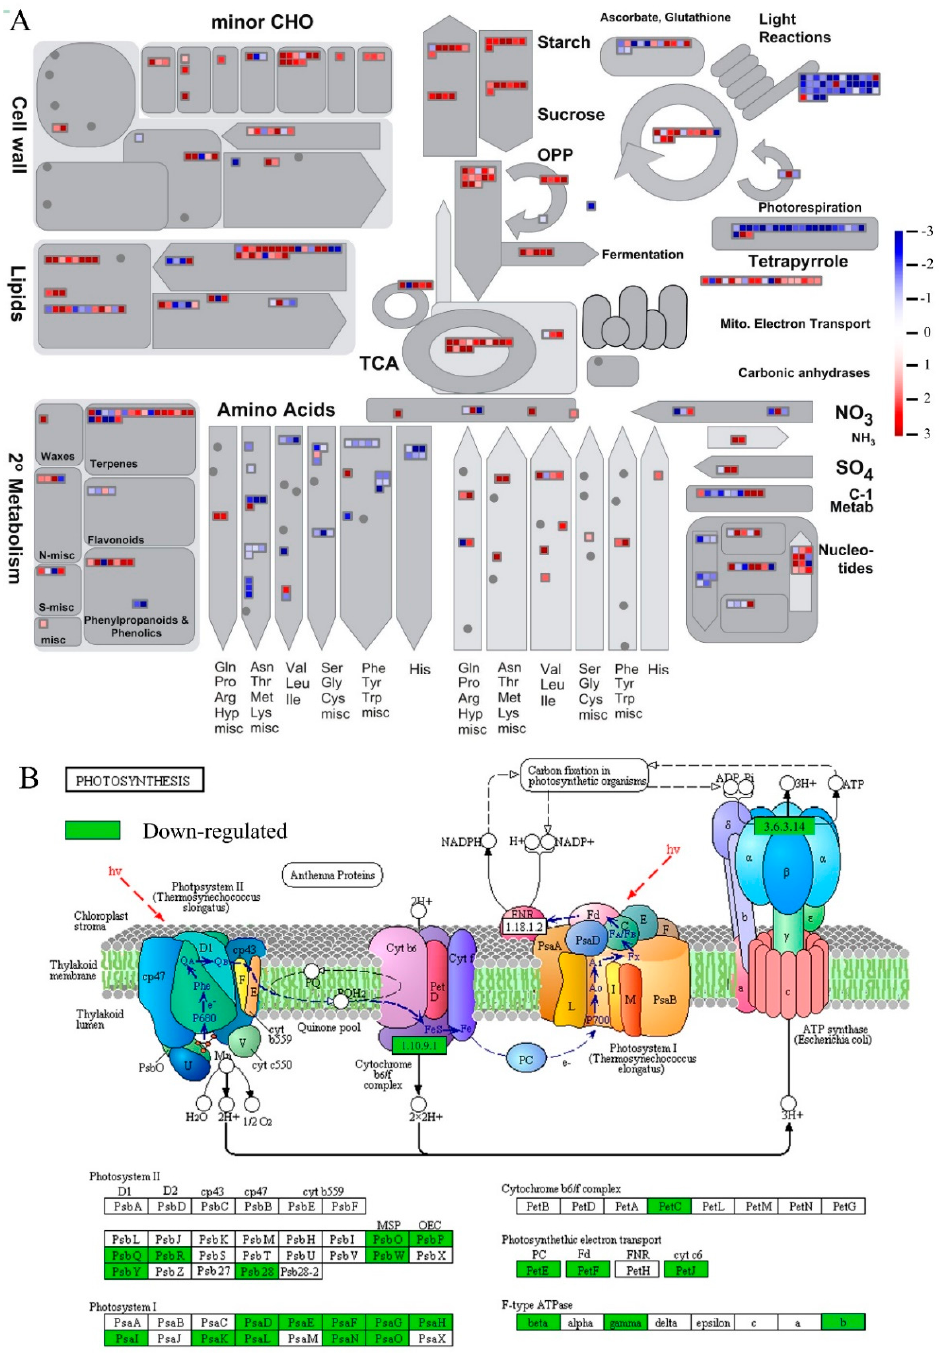
Figure 2. ( A ) Global view of differently expressed genes (DEGs) involved in diverse metabolic pathways. DEGs genes were selected for the metabolic pathways analysis using the MapMan software (3.5.1 R2). The colored boxes indicate the Log 2 of expression ratio of DEGs genes. The dys-regulated unigenes were assigned to 1334 and 1050 homologs in Arabidopsis, respectively. These genes were mapped to 797 pathways by MapMan, of which, 22 pathways were filtered enriched by the dys-regulated genes with the cutoff p -value < 0.05. ( B ) The KEGG pathways (ko00195) “photosynthesis” mapped with 44 down-regulated unigenes. The down-regulated genes are marked by a green frame. The black solid line with a black arrow means molecular interaction or relation; the black dash line with a black arrow means indirect link or unknown reaction; the red dash line with a red arrow stands for the light quanta.